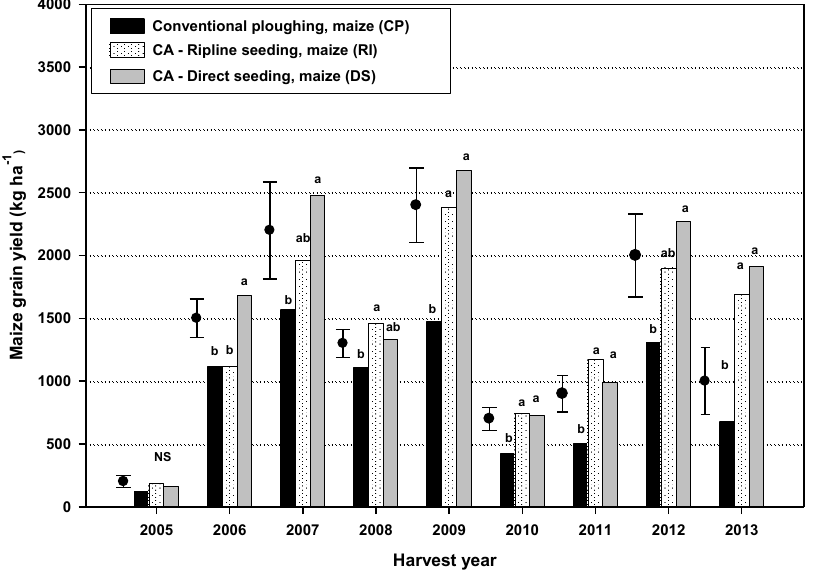
Figure 2. Long-term effects of a conventional and two conservation agriculture treatments on maize grain yield (kg·ha –1 ) in Zimuto Communal Area, Masvingo Province, Zimbabwe, 2005–2013. The error bars indicate the standard error of the difference (SED) at p ≤ 0.05. Adapted from